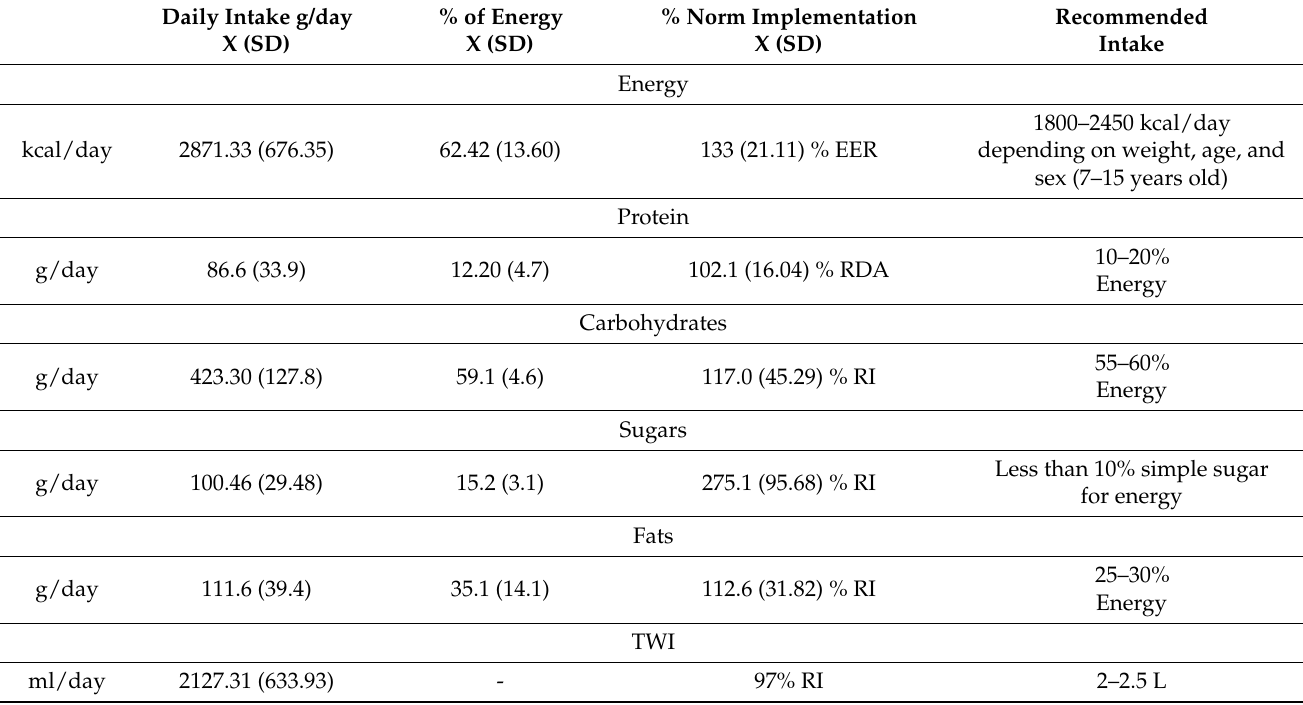
Table 2. Daily energy, macronutrients, TWI intake, and norm implementation in the studied